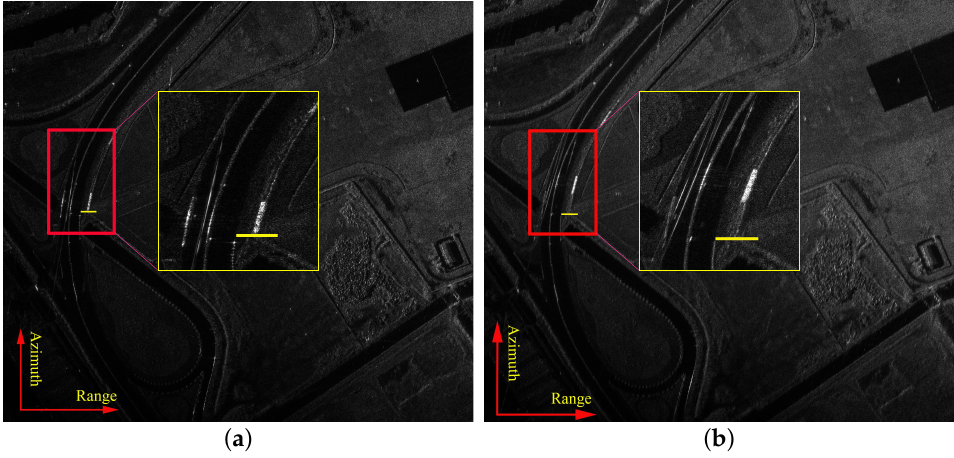
Figure 20. ViSAR image of urban scene. ( a ) Frame 17 and ( b ) Frame